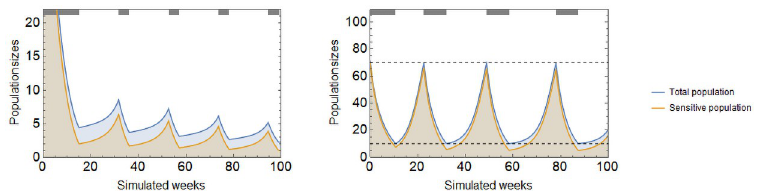
Fig 5. Adaptive therapy conditioned on tumor size and composition. Cytotoxic therapy conditioned on the tumor’s composition can lead to the extinction of the tumor (left), while therapy conditioned on tumor size can lead to persistent cycles (right). Therapy is turned off when g ( t ) ( x ( t )) falls below the lower bound g ( x ) and it is turned on again when it rises above the upper bound � g ( � x ). Parameters: r 1 = 0.4, r 2 = 0.2, d 1 = d 2 = 0, K = 150, c 1 = c 2 = 0.05, m 1 = m 2 = 0.01, α = 2, γ 1 = 0.4, γ 2 = 0, g ¼ 45% , � g ¼ 75% , x ¼ 10 , � x ¼ 70